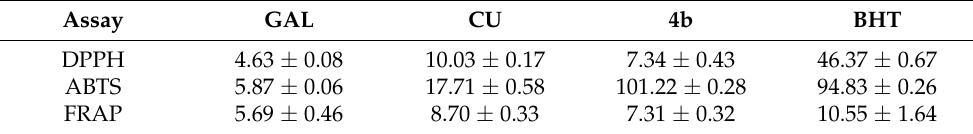
Table 3. Antioxidant activity (by DPPH, ABTS and FRAP assays) for GAL, CU and 4b . Values are given in µ M TE/mM ± standard deviation ( n = 3). Butylhydroxy toluol (BHT) was used as